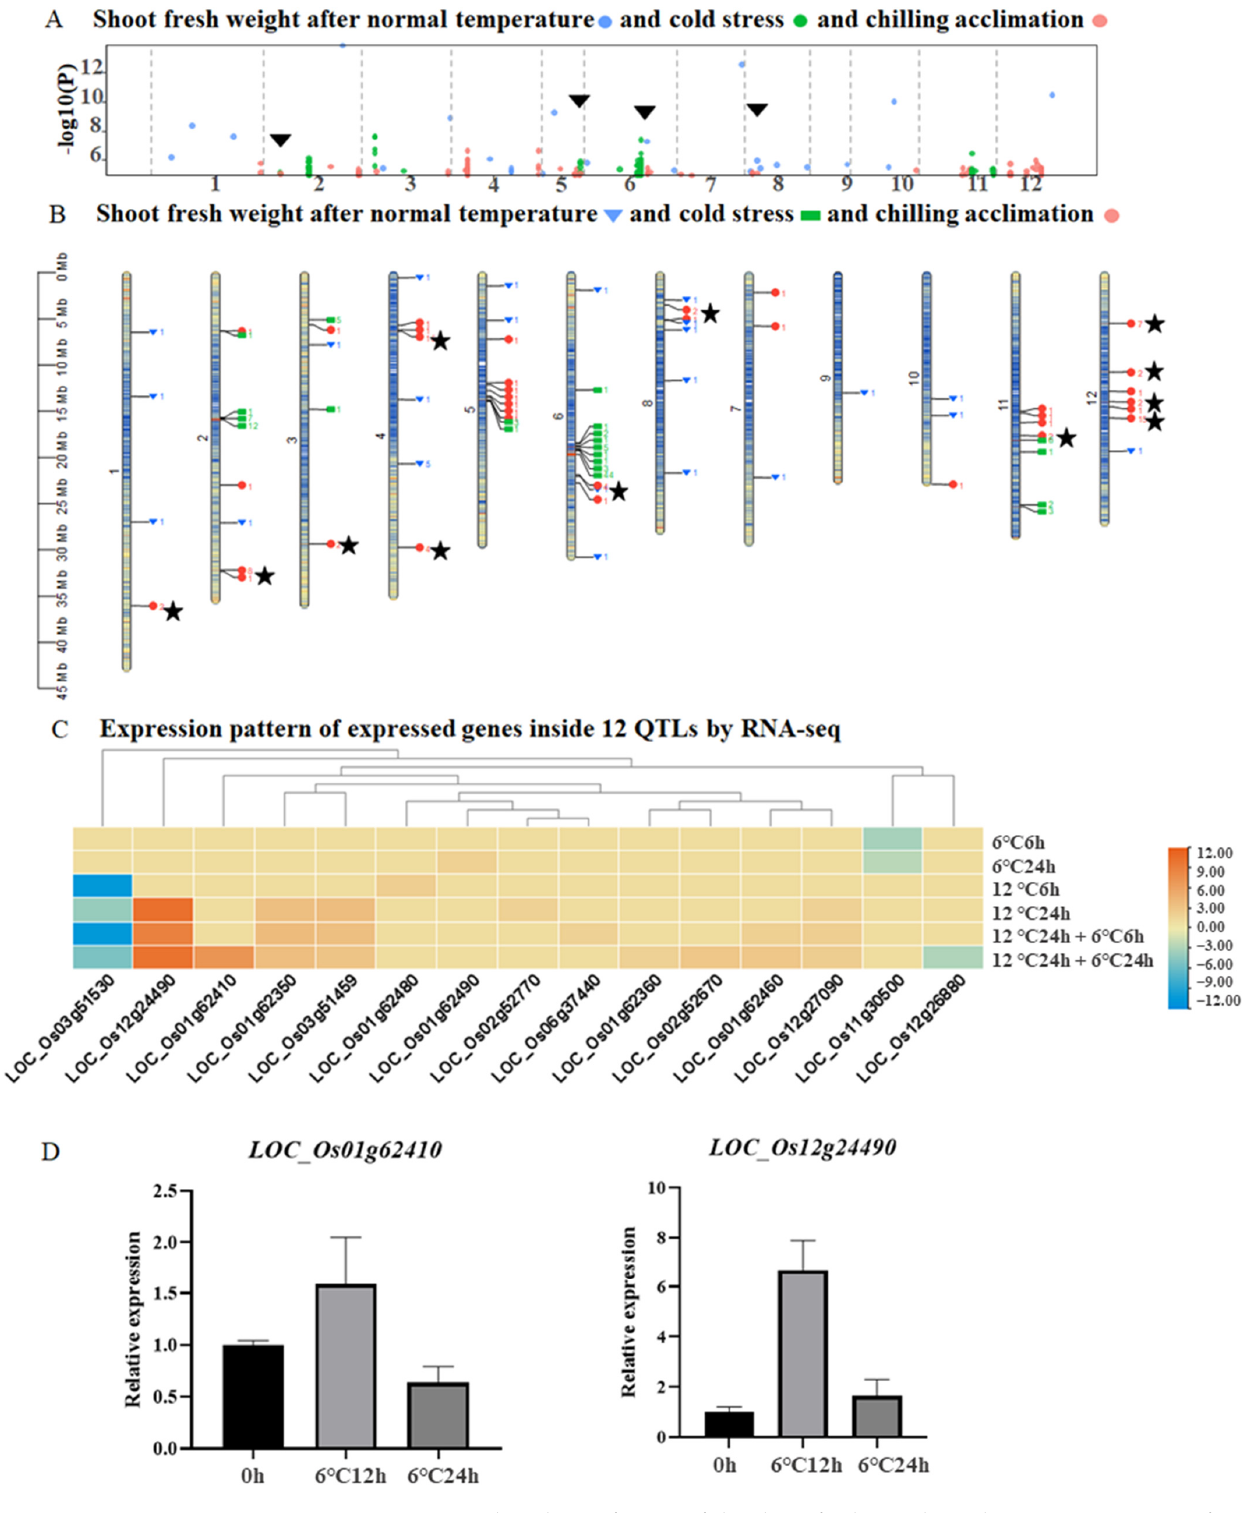
Figure 4. Integrated analysis of SNPs of the shoot fresh weight and expression pattern of genes in 12 QTLs. ( A ) Comparison of the QTL results under three different temperature conditions. ( B ) Distribution of SNPs on different chromosomes. Stars represent QTLs with two or more SNPs and that were specifically detected under chilling acclimation. ( C ) Expression pattern of 15 genes of 12 QTLs. ( D ) Relative expression of LOC_Os01g62410 and LOC_Os12g24490 by